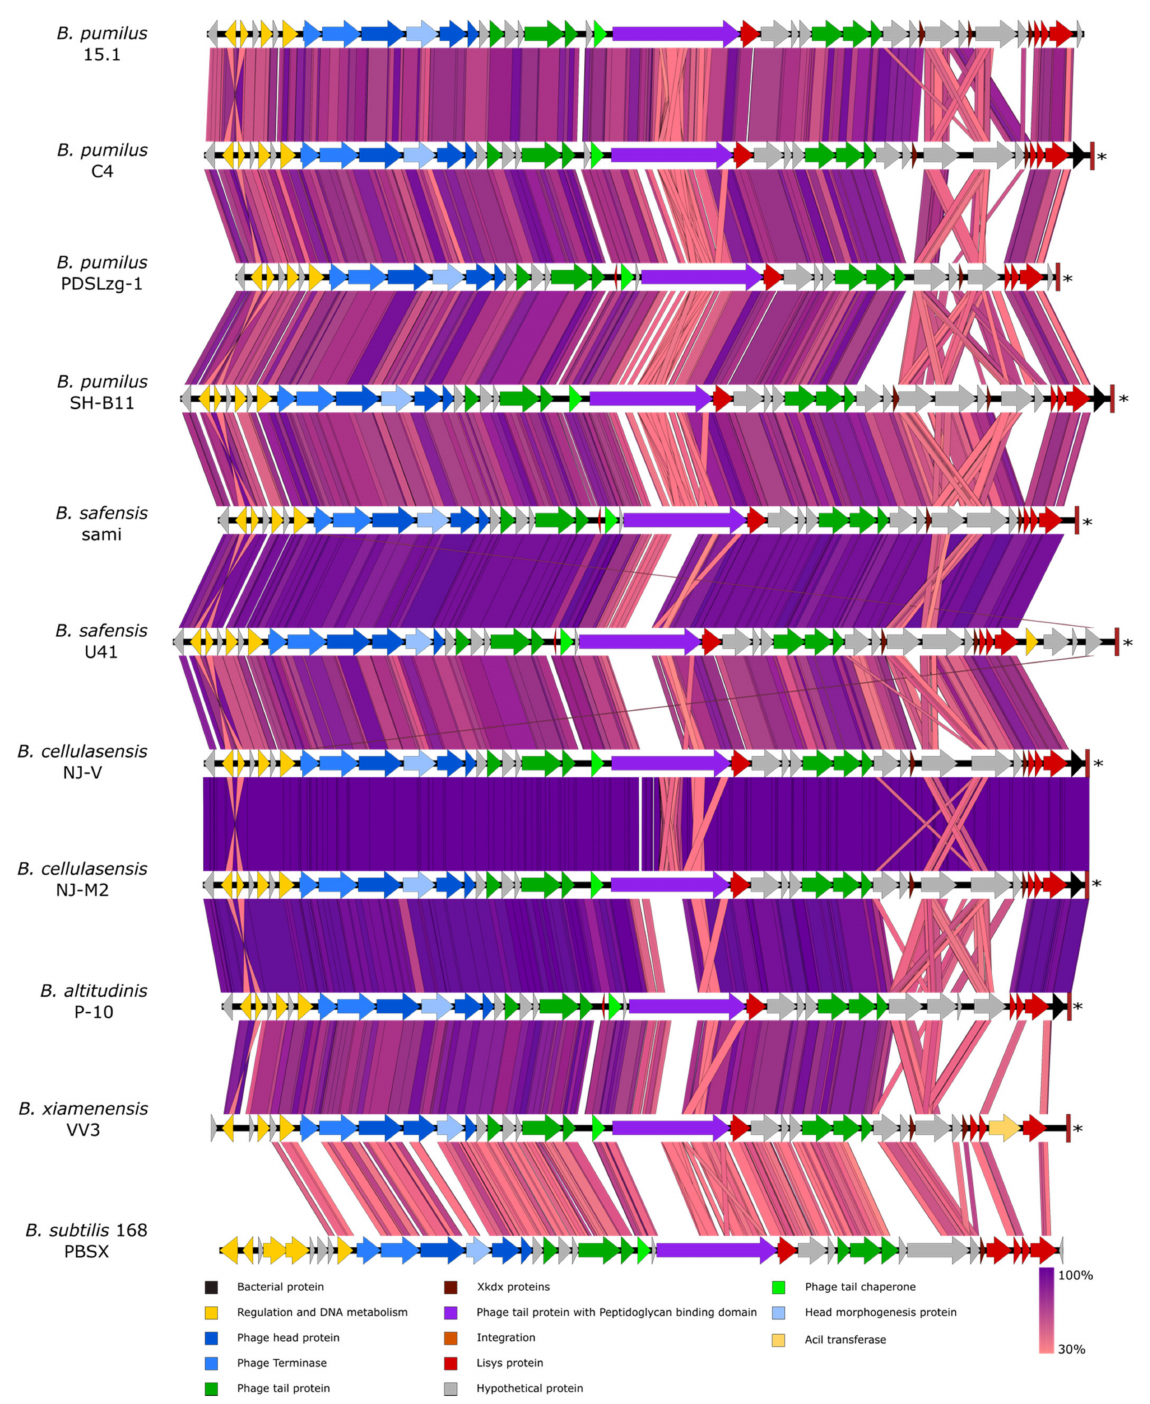
Figure 3. Comparative analysis of the PBSX-like regions among different B. pumilus related species. The potential function of each ORF was inferred by Blastp and shown as coloured arrows. tRNAs are indicated by asterisks. Homology studies were made by tBlastx and plotted with Easyfig with a minimal length of 50